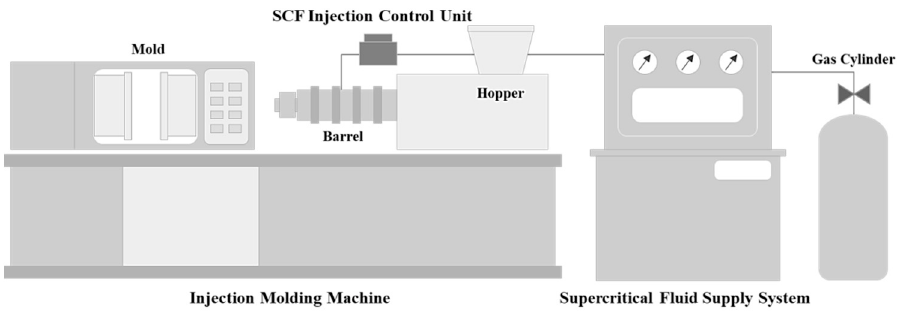
Figure 1. Microcellular foaming process applied to the injection molding process.